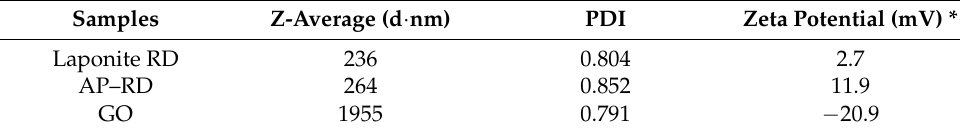
Table 1. Average particle size, PDI and Zeta potential of Laponite RD, AP–RD and